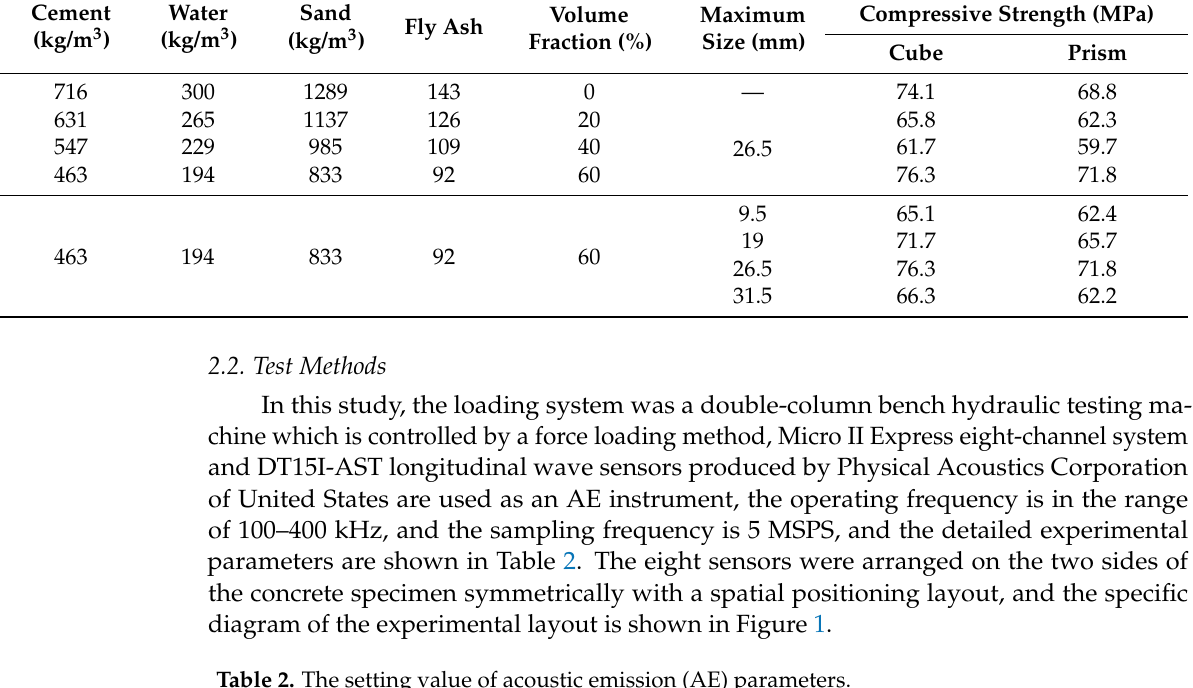
Table 2. The setting value of acoustic emission (AE)